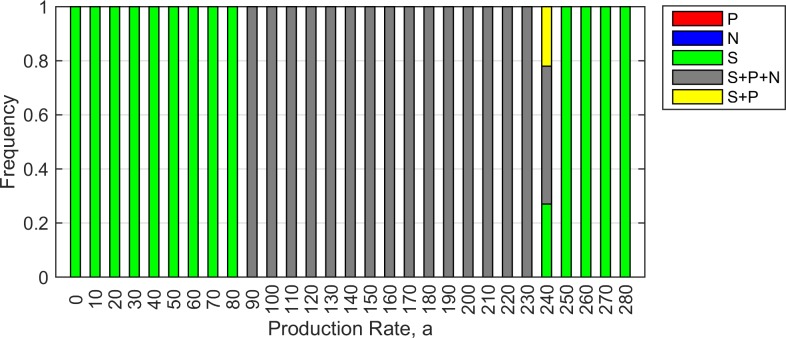
Possible outcomes of 100 simulation trials for each value of production rate a in the presence of mutation between P and N.Green–S only; red–P only; grey–S, P and N; yellow–S and P. Parameters: r1 = 2, r2 = 2.5, v = 1, b = 10, c = 0.001, δt = 0.01, u = 10−4. This should be compared with Fig 4 for the case with no mutation. Results are much more predictable when mutation is present.